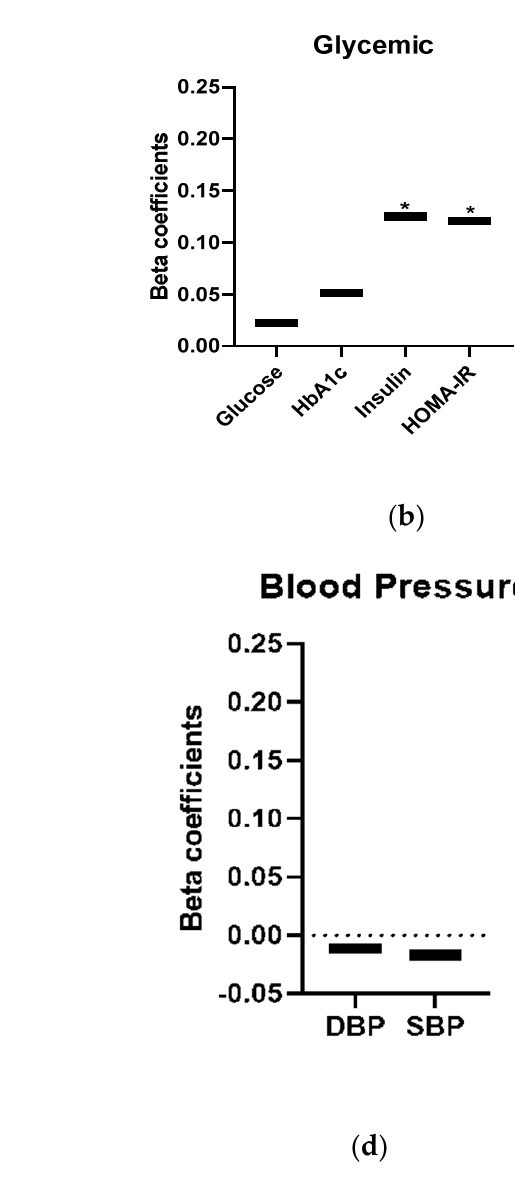
Figure 2. ( a – d ). Baseline associations between cardio-metabolic parameters and body fat and RQ. Linear regression model adjusted for age, sex, and baseline BMI. Amount and direction of association between baseline RQ values and biomarkers are represented by β -standardized coefficient. n = 277. * p < 0.05; ** p < 0.01; *** p < 0.001. Abbreviations: DBP—diastolic blood pressure; DSAT—deep subcutaneous adipose tissue; HbA1C—glycated hemoglobin; HOMA-IR—homeostatic model of insulin resistance; HDL—high-density lipoprotein cholesterol; IMAT—intermuscular adipose tissue; IMTG intramuscular triglycerides; LDL—low-density lipoprotein; RQ—respiratory quotient; RS—renal sinus; SBP—systolic blood pressure; SSAT—superficial subcutaneous adipose tissue; TG—triglycerides; VAT—visceral adipose